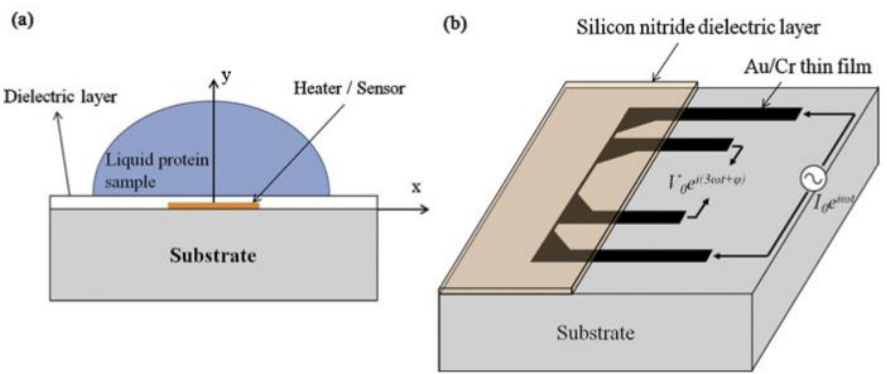
Figure 2. ( a ) Schematic diagram of 3 ω technique for measuring k (thermal conductivity) of liquid sample and ( b ) schematic diagram of thermal conductivity sensor. Reprinted/adapted with permission from Ref. [29].